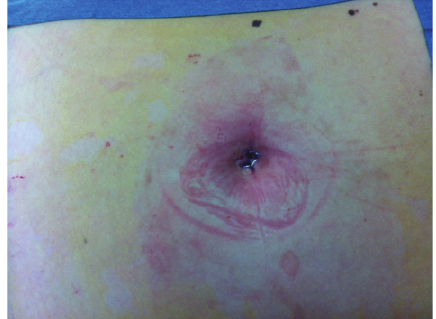
Figure 5: The umbilical scare at the end of a procedure.